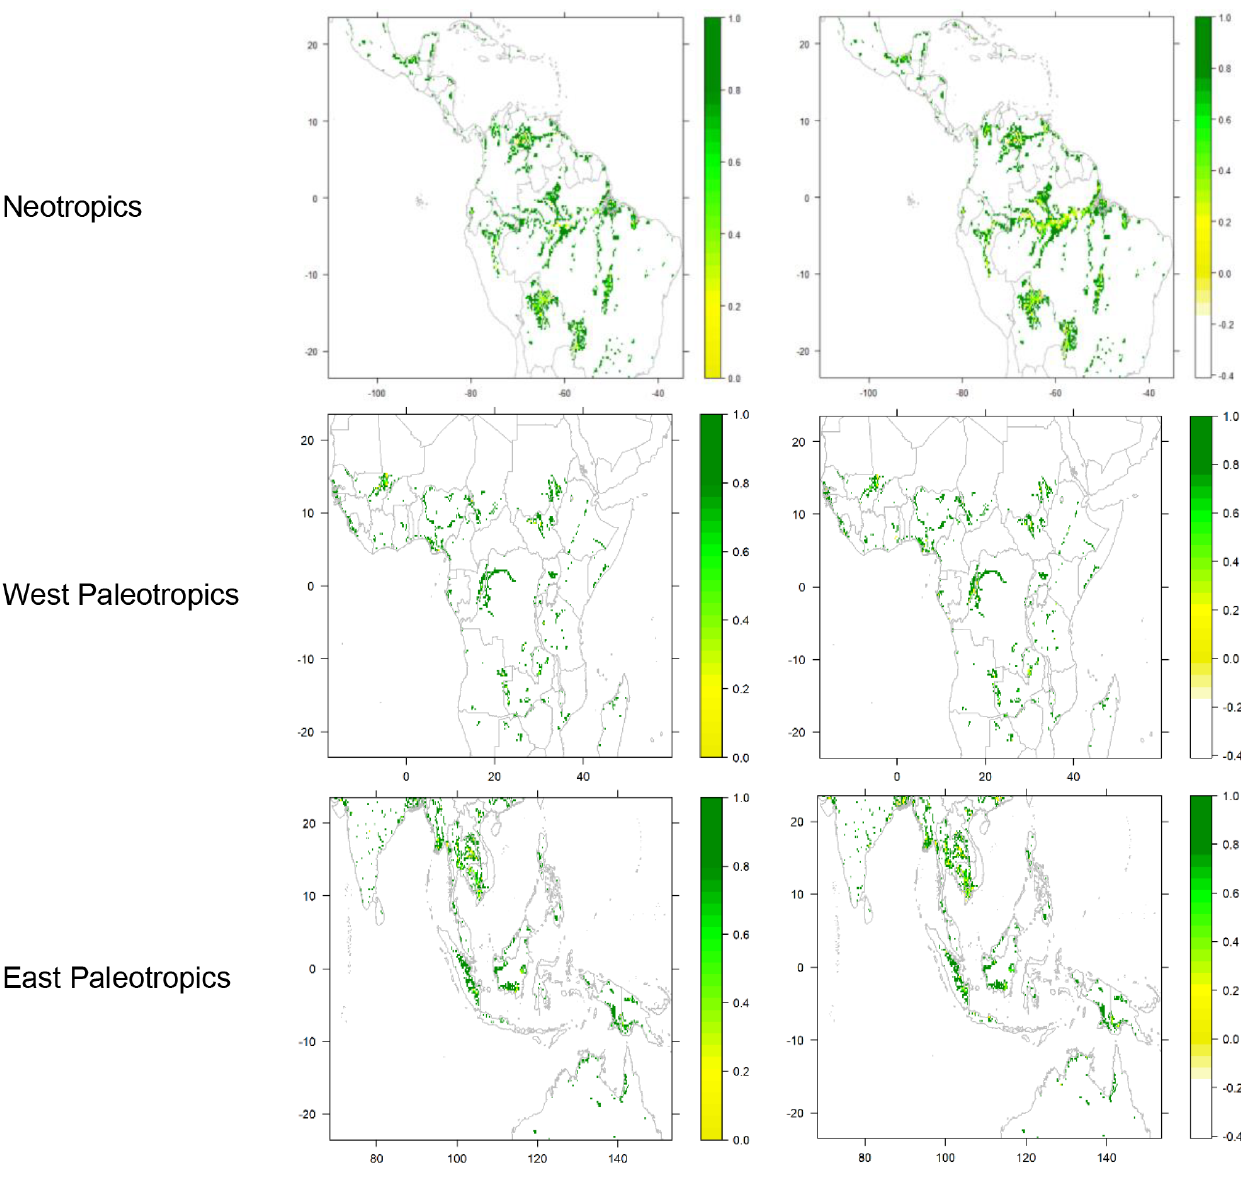
Figure 5. Mapped values for efficiency statistics based on inundated grid-cell fraction, averaged across the years 1992–2014 (with α min = 0 . 0, β = 0 . 0 and α max = 1 . 0) (white indicates no value could be